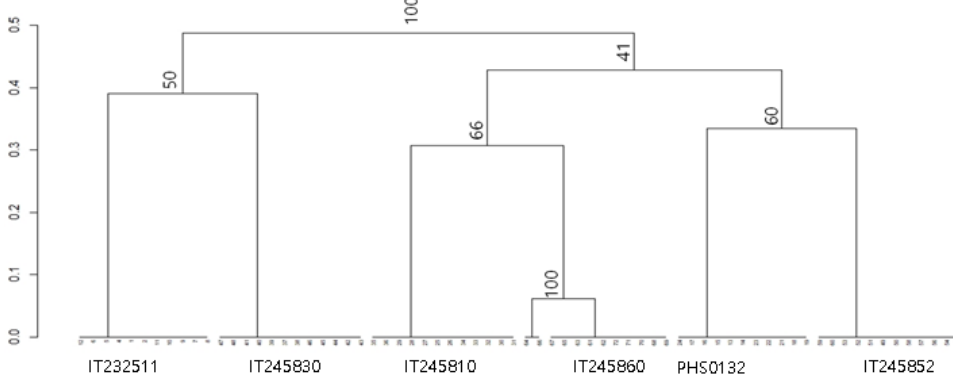
Figure 4. A UPGMA dendrogram showing the genetic distance of six strawberry accessions containing three samples of four treatments (GH, greenhouse maintained; TC, tissue culture; +LN, liquid nitrogen exposure; − LN, non-liquid nitrogen exposure). * The bootstrap percentage values are shown on nodes.